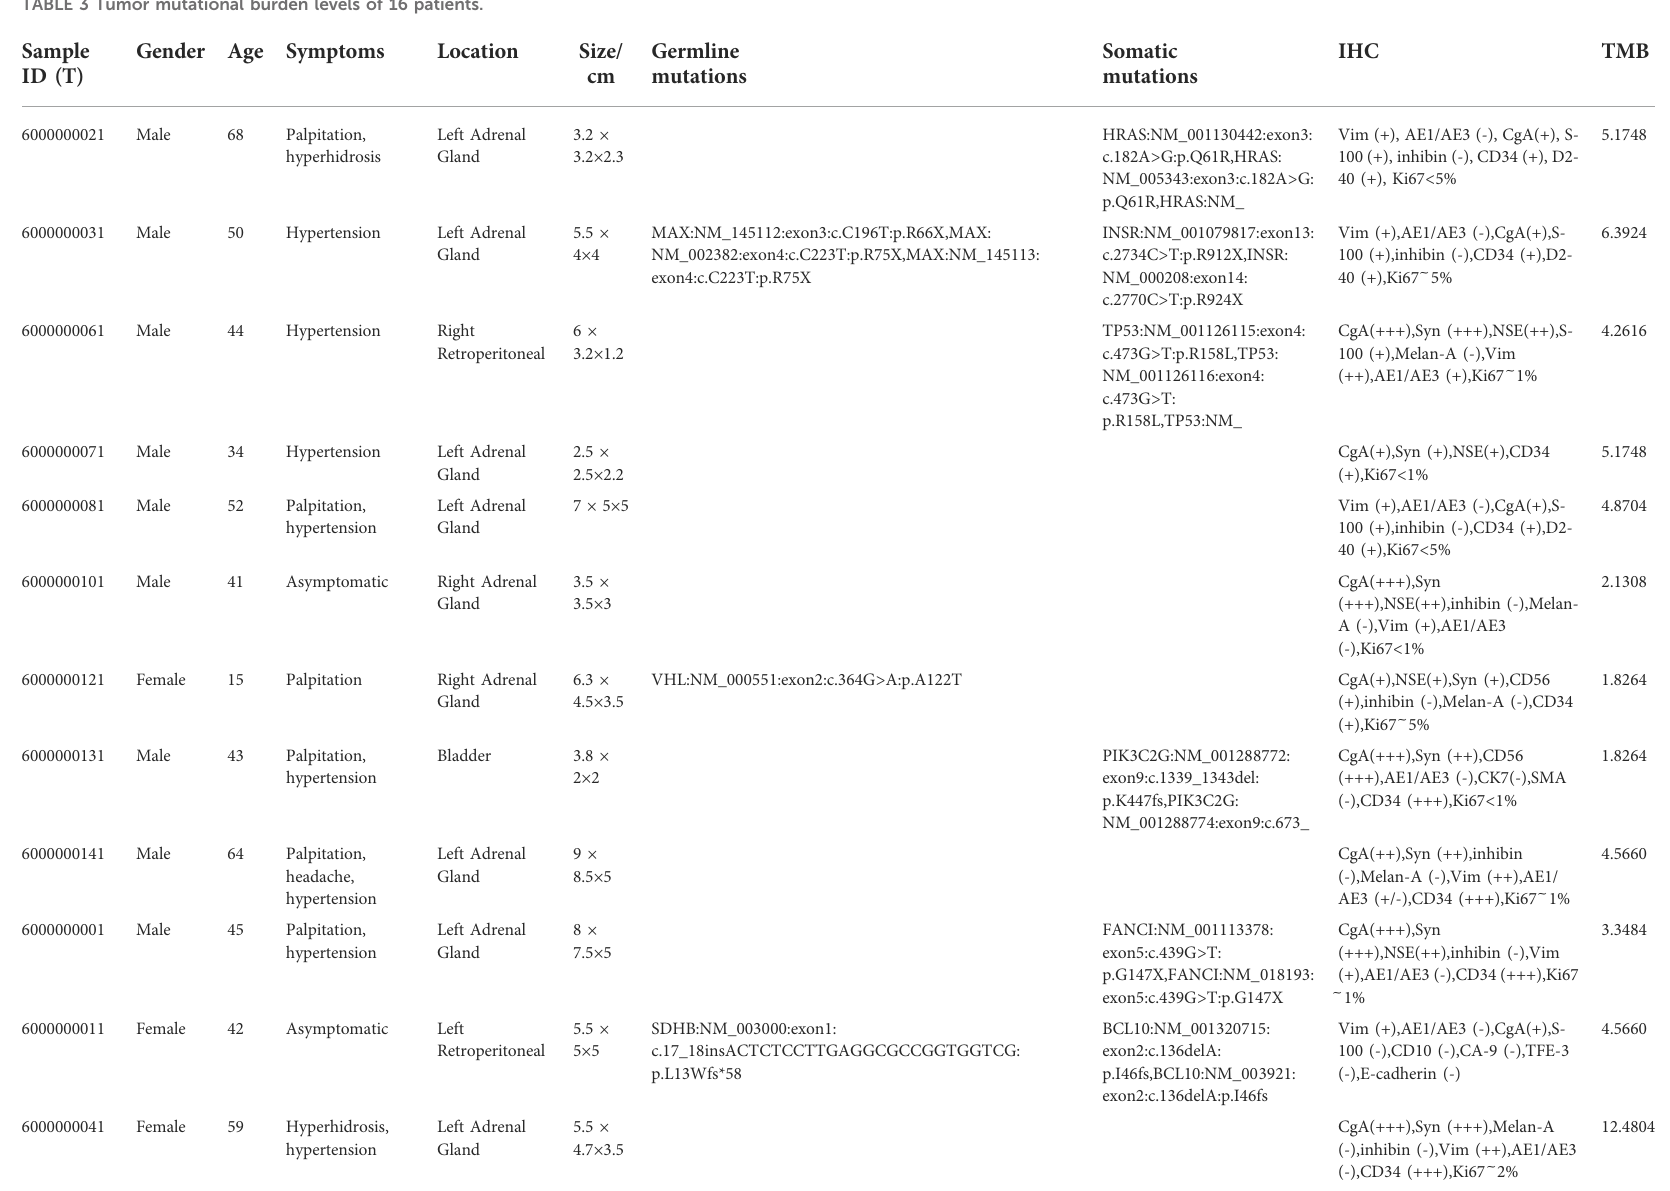
TABLE 3 Tumor mutational burden levels of 16